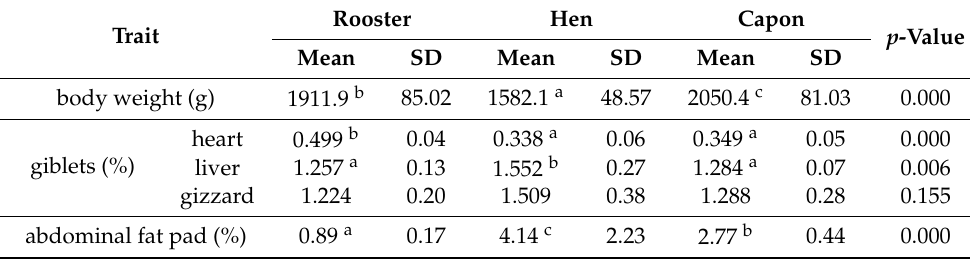
Table 3. The carcass parameters of birds depending on their sex.